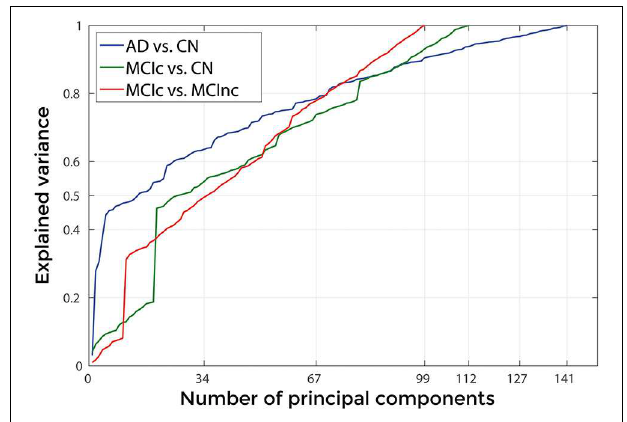
FIGURE 9 | Explained Variance, when using the best set of optimal parameters, as a function of the number of considered principal components sorted in accordance to their FDR, for the following comparisons: AD vs. CN, MCIc vs. CN, MCIc vs.